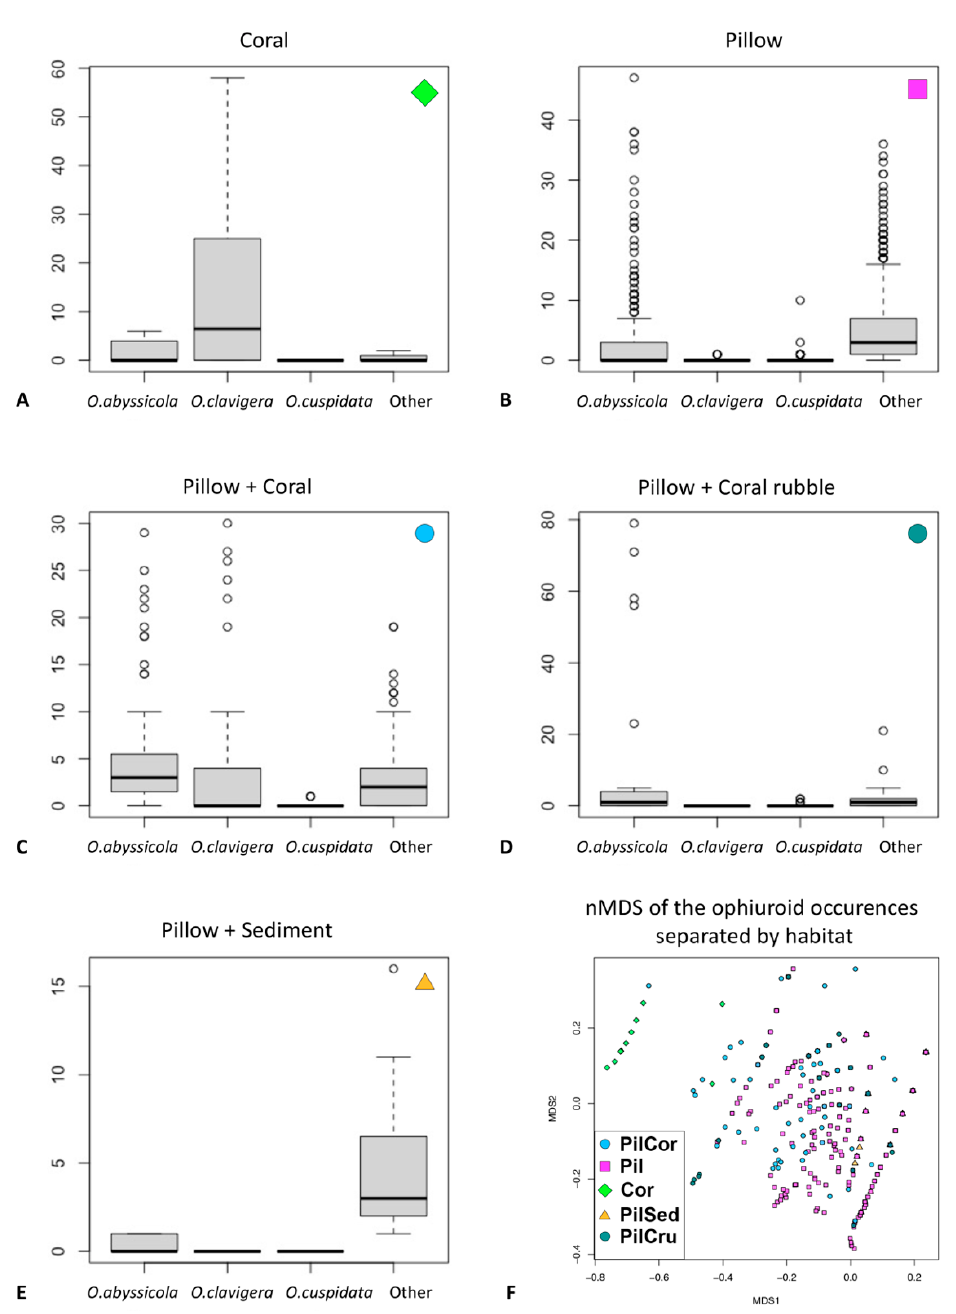
Figure 6. ( A – E ): The boxplots illustrate the proportional abundance of Ophiomyxa serpentaria Lyman, 1883 ; Ophiolebes bacata Koehler, 1921; Ophiomitrella clavigera (Ljungman, 1865) ; Ophiactis abyssicola (M. Sars, 1861); and Ophiacantha cuspidata Lyman, 1879 relatied to each habitat: ( A ): “Coral” (Cor); ( B ): Pillow” (Pil); ( C ): “Pillow + Coral” (PilCor), ( D ): “Pillow + Coral Rubble” (PilCru); ( E ): “Pillow + Sediment” (PilSed). ( F ): The distribution of the ophiuroid fauna depending on the habitat presented by Nonmetric Multidimensional Scaling (nMDS).